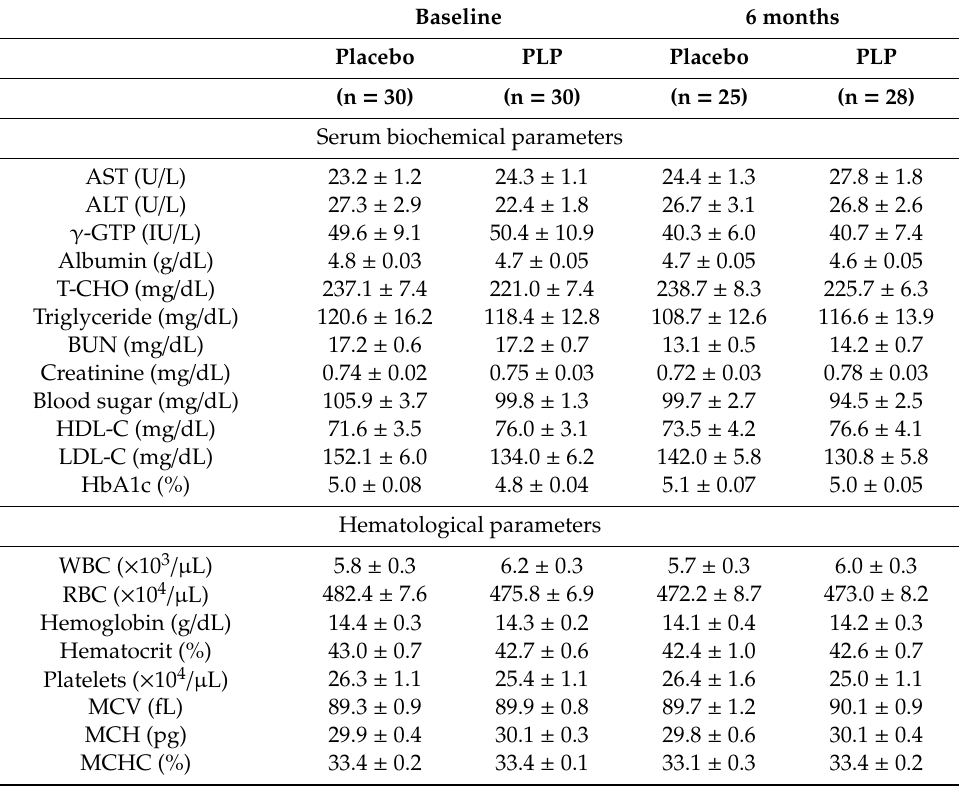
Table 2. Serum biochemical and hematological parameters of